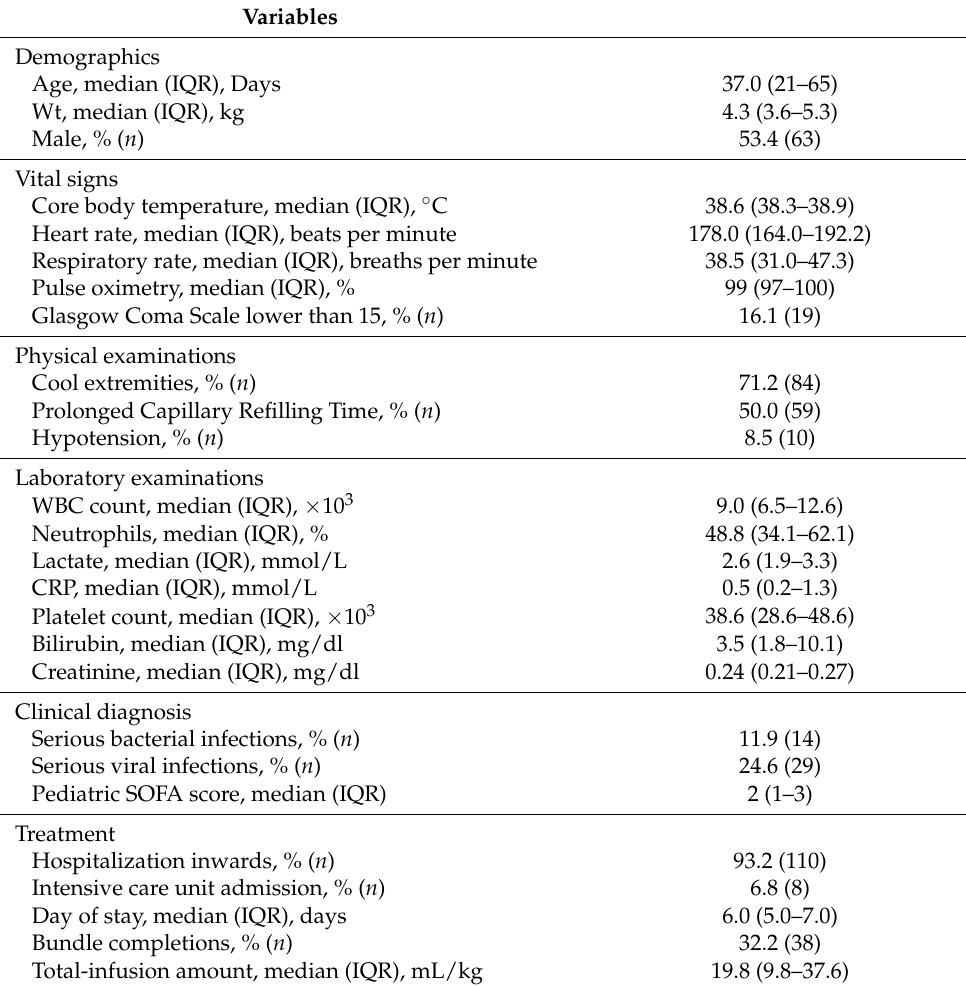
Table 1. Clinical characteristics of patients ( n =